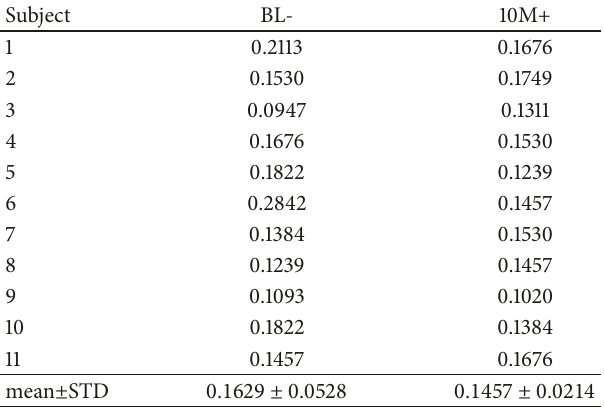
Table 5: Lempel–Ziv Complexity individual, mean, and standard deviation (STD) values of the two classes studied, BL- and 10M+. No significant differences between groups were found ( 𝑝 = 0.2920 ,